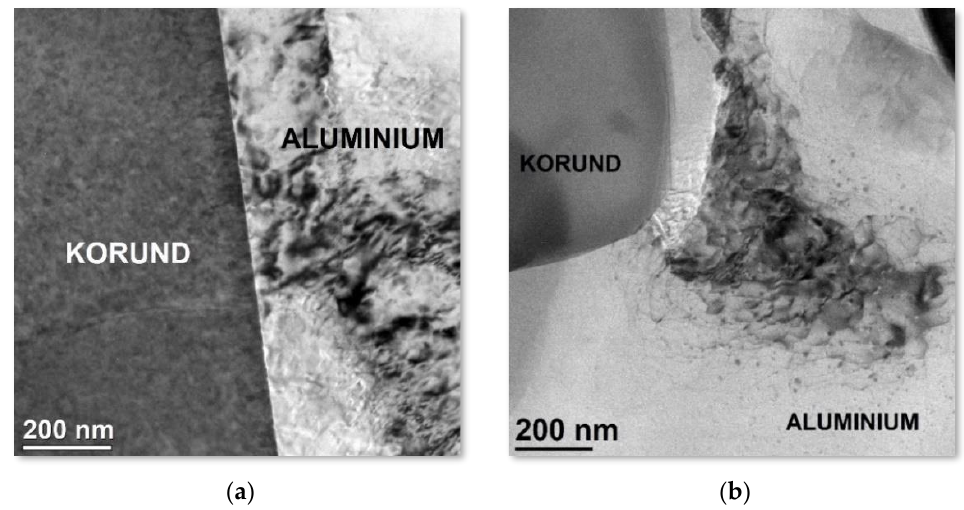
Figure 11. STEM-BF images of ( a ) the interface between alumina and aluminium, ( b ) revealing the influence of the hard phase on the increase in the deterioration of the aluminium structure.